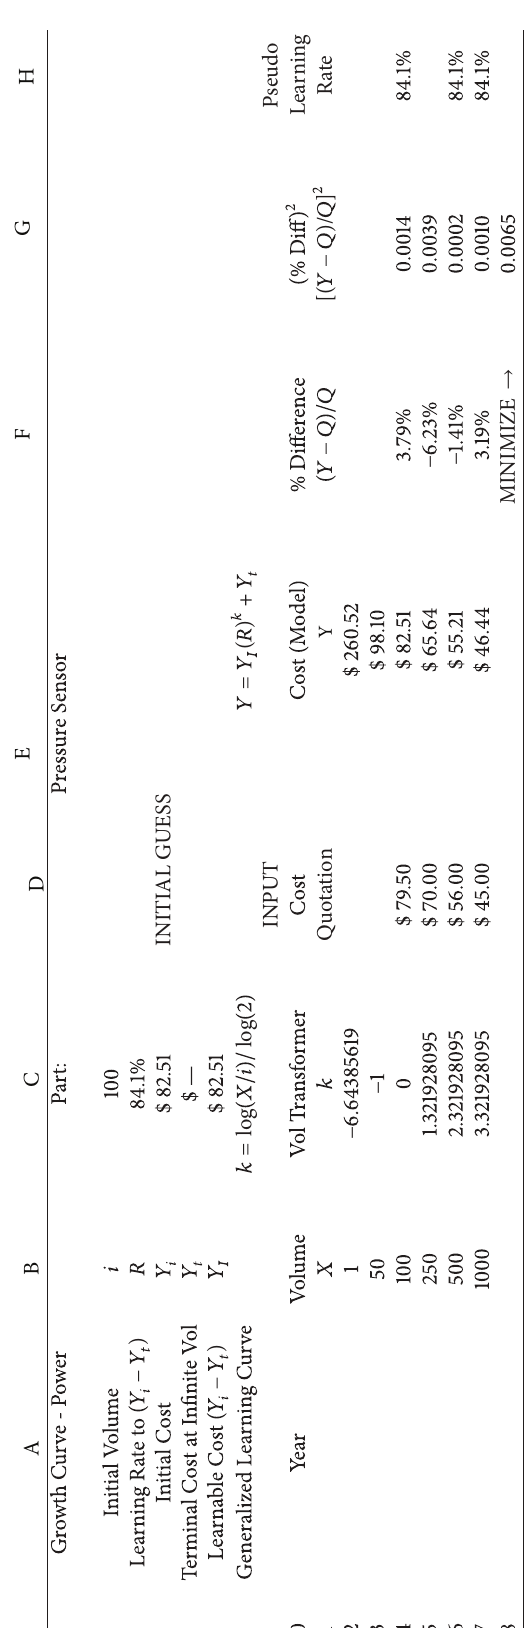
Figure 6: Model summary for pressure